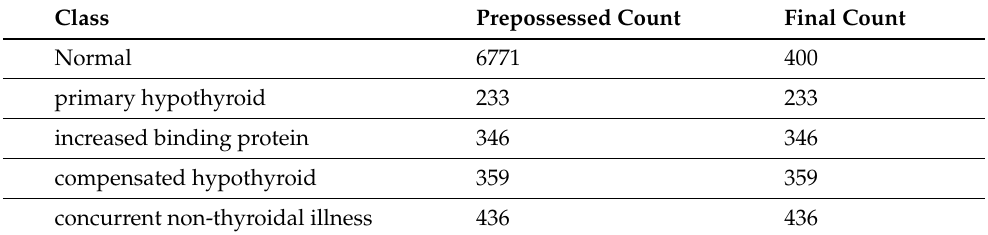
Table 5. Balanced dataset for Thyroid disease